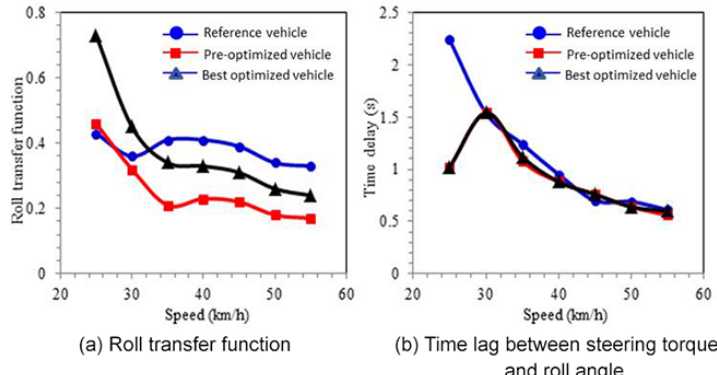
Figure 25. Evaluation index of slalom.